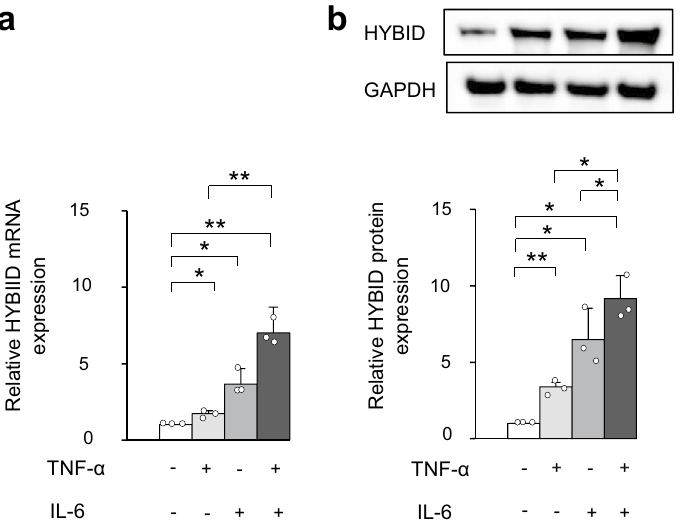
Figure 4. Additive effect of the HYBID expression by TNF-α and IL-6 in OA chondrocytes. ( a ) and ( b ) Effects of TNF-α and IL-6 on the mRNA and protein expression of HYBID in OA chondrocytes, respectively. OA chondrocytes at P2 were treated with TNF-α (0 or 10 ng/ml) and/or IL-6 (0, 100 ng/ml) in the presence of sIL-6R (100 ng/ml) for 24 h and 48 h, and cell lysates were subjected to quantitative real-time PCR for HYBID expression using the ΔΔCt method ( a ) and immunoblotting with anti-HYBID antibody, followed by densitometric analysis ( b ). The average HYBID:GAPDH ratio in control OA chondrocytes treated with vehicle was set at 1. Values are expressed mean ± SD (n = 3). *, P < 0.05; **, P < 0.01. The uncropped full-length gels are presented in Supplementary Figure